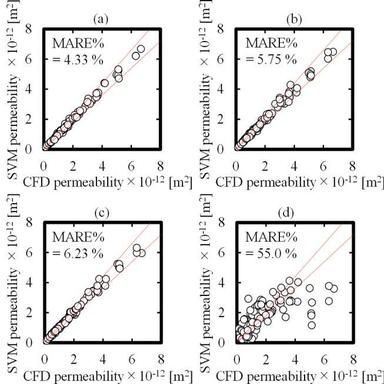
Results of permeability prediction using different SVM models. The horizontal and vertical axes represent the permeability estimated by the CFD simulation (supervised data) and the SVM models (prediction result), respectively. The red lines represent 10% errors. Four SVM models were constructed using different descriptor subsets: (a) selected, (b) conventional, (c) FS, and (d) low-rank sets.